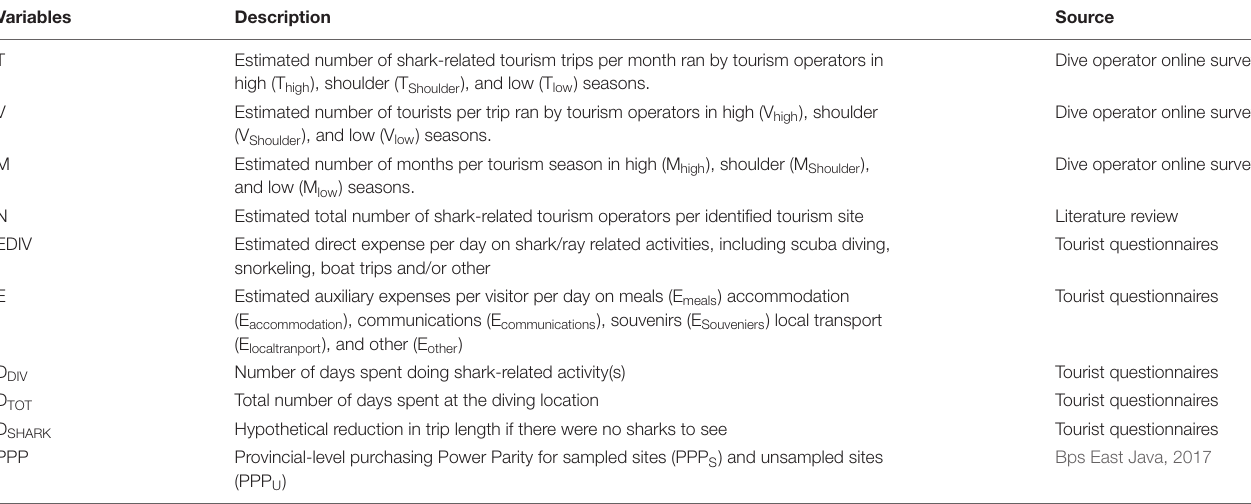
TABLE 2 | Description of constants and parameters used to estimate revenue generated by shark and ray tourism in Indonesia.